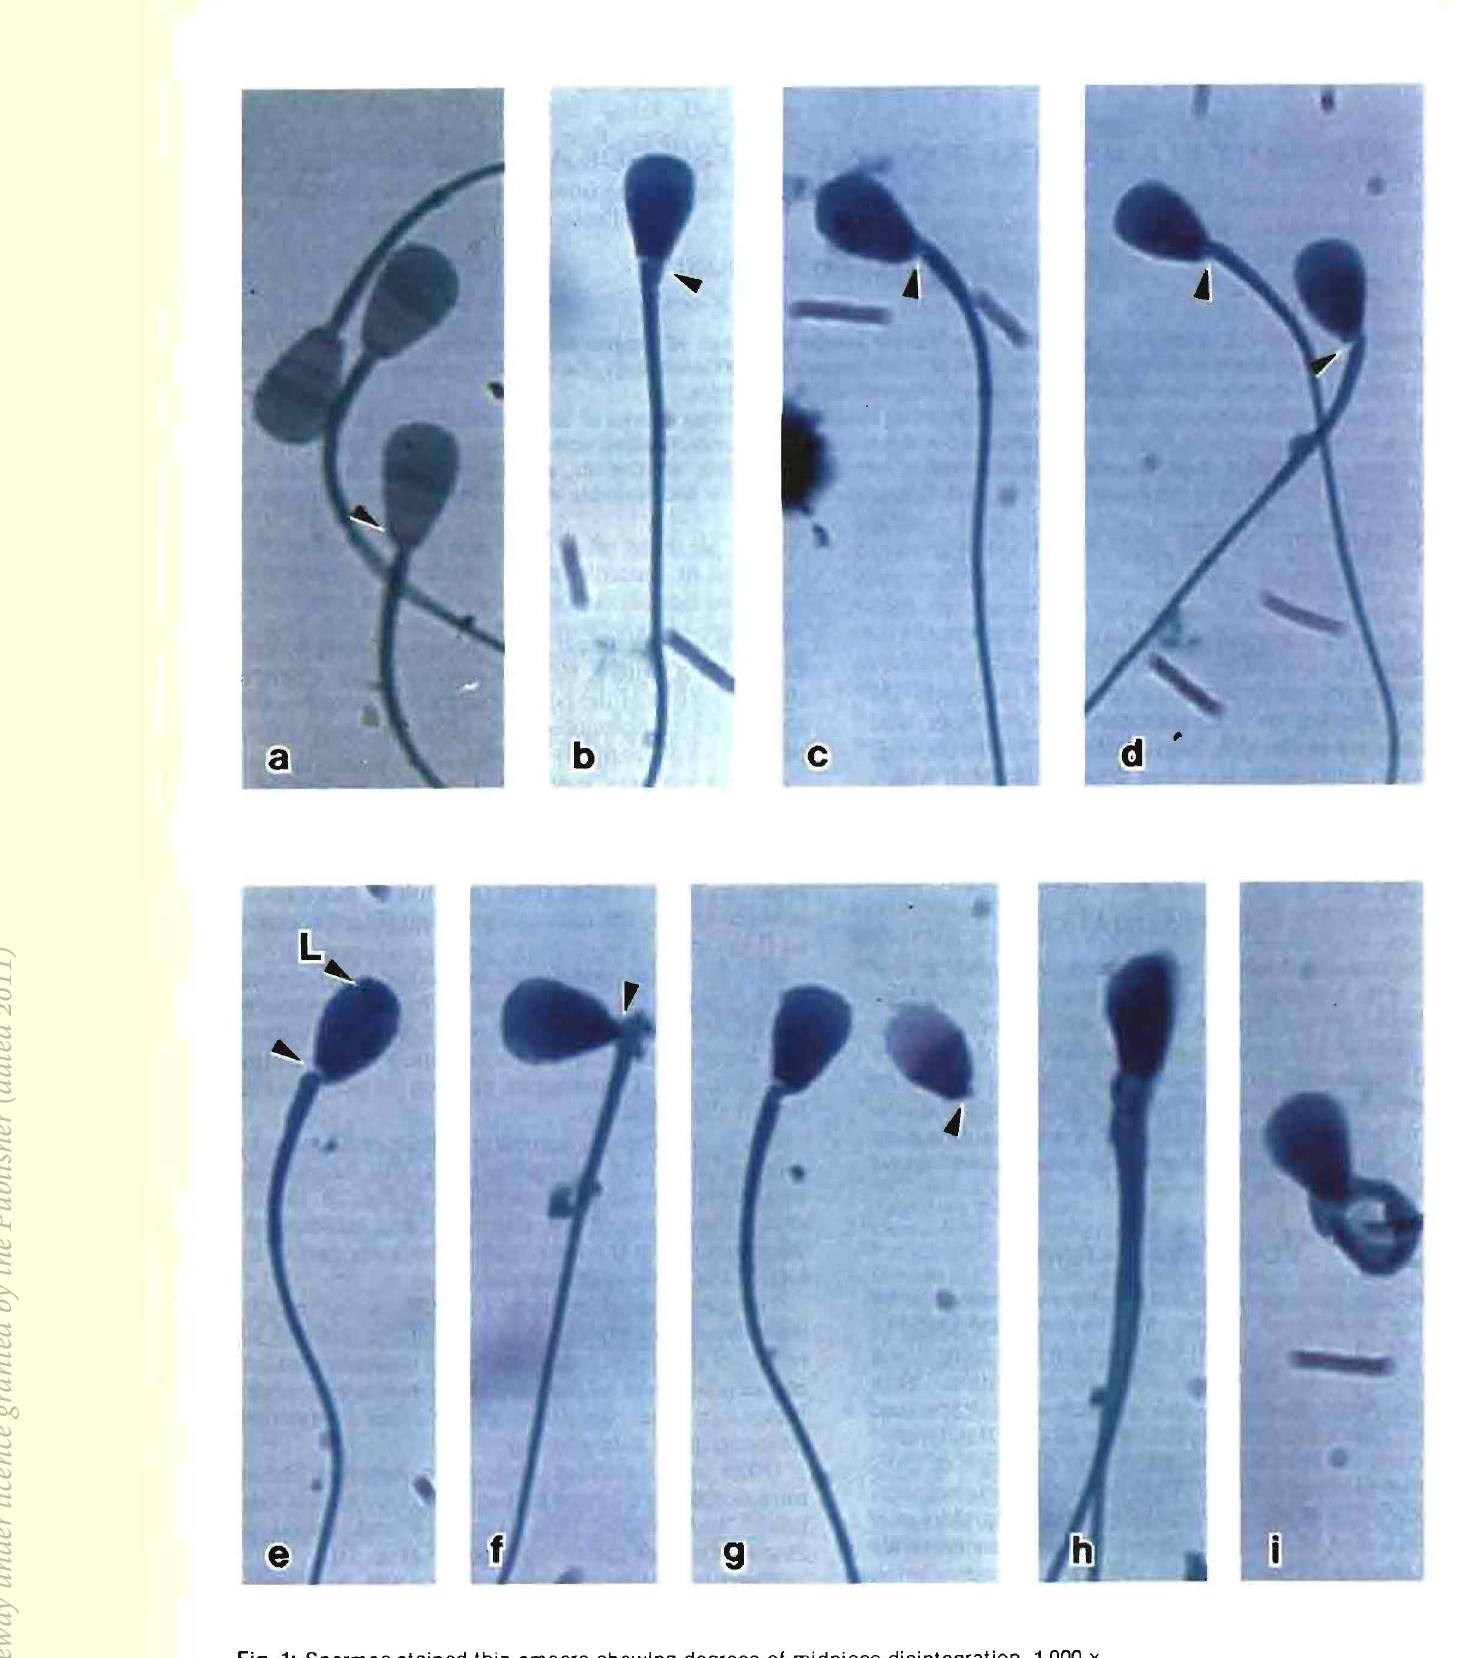
Fig. 1: Spermac·stained thin smears showing degrees of midpiece disintegration. 1000 x a) Normal sperm. Note width of head base. b) Swelling of the midpiece. c) Bending of midpiece. Note rounding of head